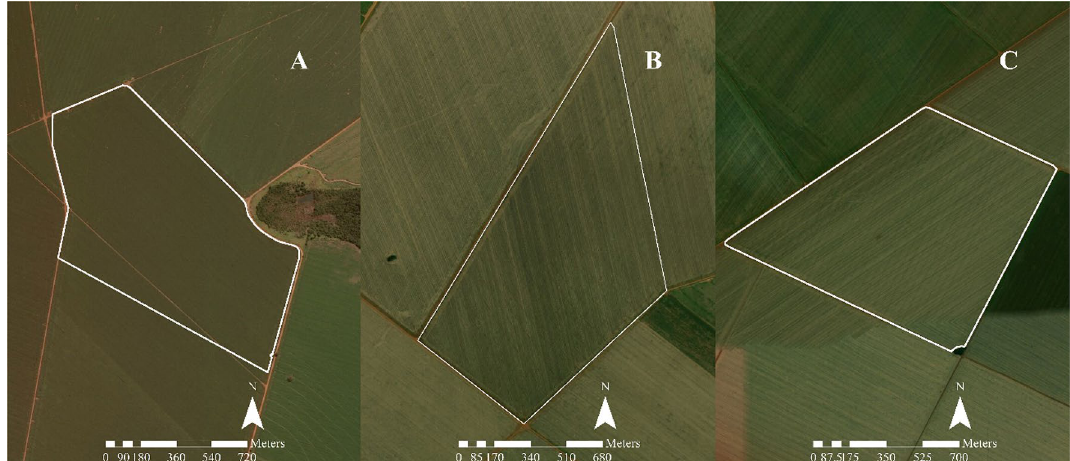
Figure 1. Experimental sites in the Alto Formoso ( A ) and Porto Seguro ( B , C ) farms. The software used to create this Figure was ArcGIS Desktop (v10.5, https:// deskt op. arcgis. com/ en/ system- requi remen ts/ 10.5/).